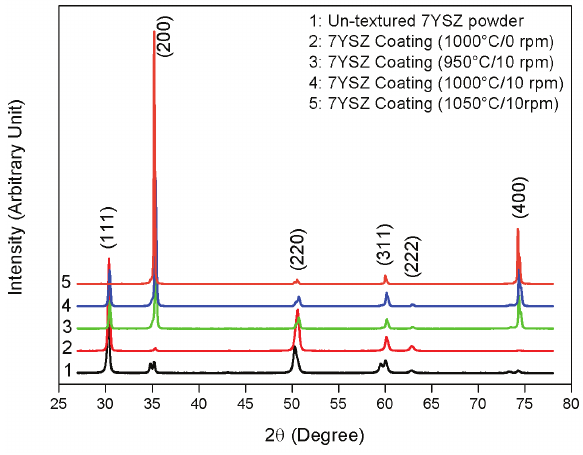
Figure 2. X-ray diffractograms for 7YSZ coating deposited using various deposition conditions. The XRD pattern cor- responding to the untextured 7YSZ powder has also been included.